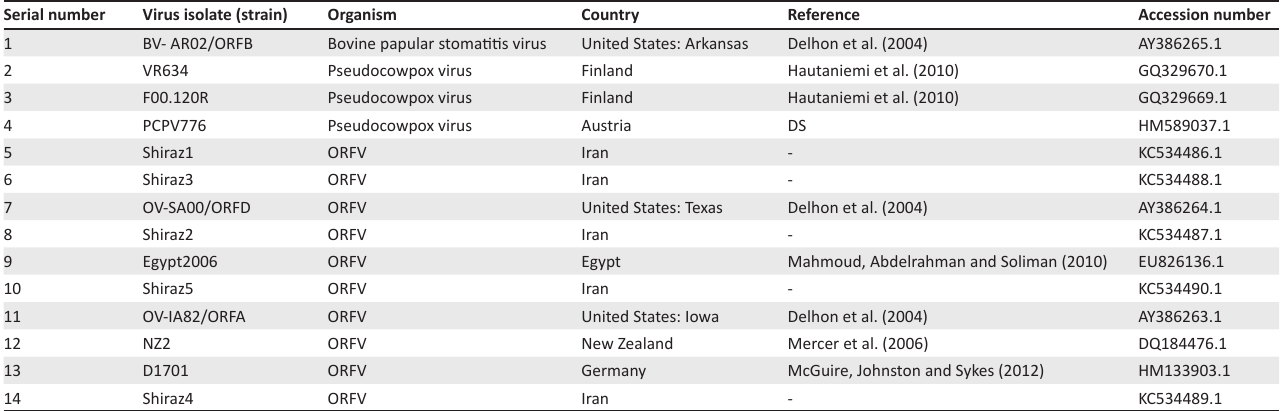
TABLE 2: Nucleotide sequences of ORF045 gene that were aligned in the samples of the present study. Serial number Virus isolate